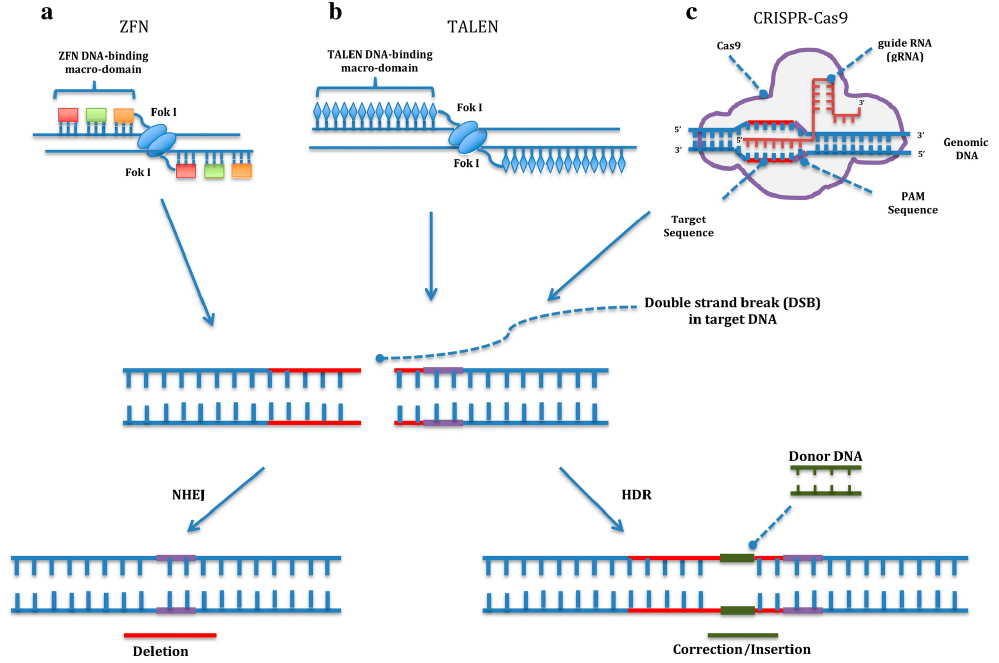
Figure 1. Genome editing with zinc finger nucleases (ZFN) ( a ), transcription activator-like effector nucleases (TALEN) ( b ) and CRISPR/Cas9 (Clustered Regularly Interspaced Short Palindromic Repeats). ( c ) First, a double-strand break (DSB) is produced in the target sequence, and then, it is repaired by non-homologous end joining (NHEJ) or homology-directed repair (HDR). NHEJ produces random insertions and deletions useful for knockout experiments, while HDR results in a precise modification of the target sequence. Reproduced with permission from Torres-Dur á n et al. [59] under the terms of